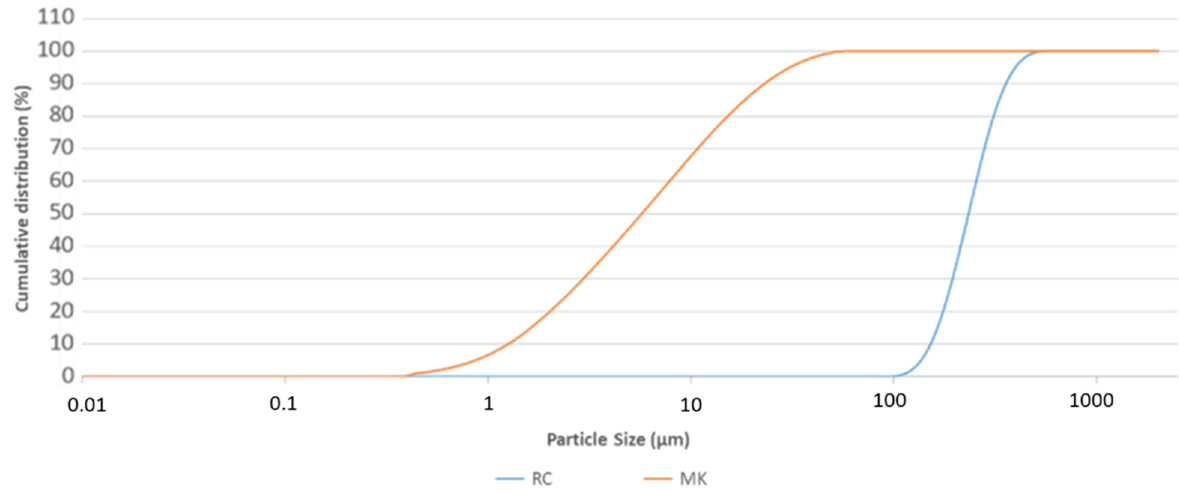
Figure 1. Comparison of particle size cumulative distribution curves of pure metakaolin (MK) and recycled corundum (RC).